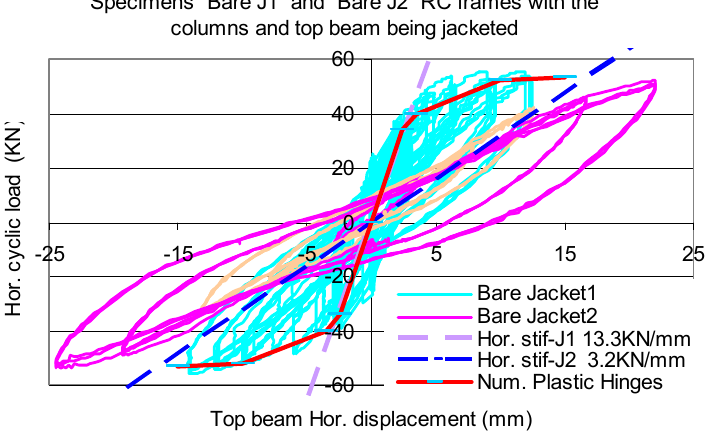
Figure 18. Horizontal displacement versus horizontal load cyclic response of specimens Bare Jacket1,2.